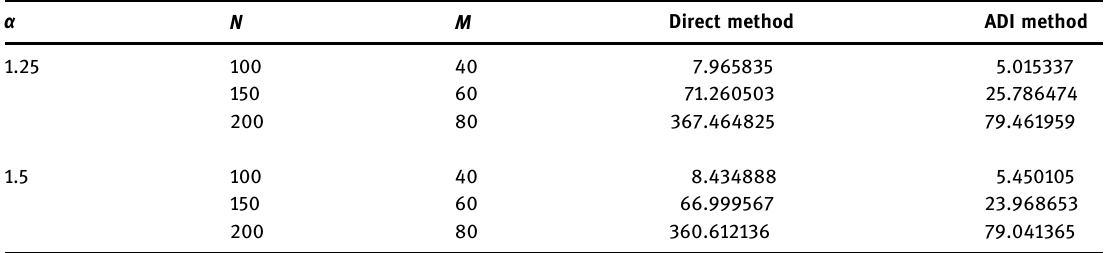
Table 3: CPU time ( s ) of the direct method and that of the proposed ADI method for Example 1